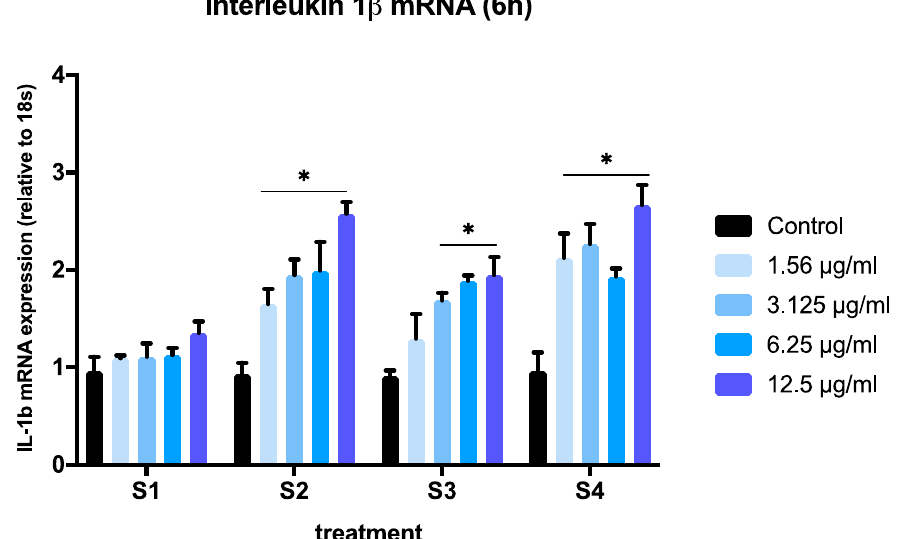
Figure 4. Expression of human interleukin-1 mRNA (IL1B) (relative to 18S expression) in BEAS-2B cell after exposure to soot preparations for 6 h. The graph summarizes data from three independent experiments ( n = 3 replicates per experiment), with results normalized to controls (exposed to methanol) and expressed as mean ± SEM. Two-way ANOVA interaction: p = 0.0109, F (12, 71) = 2.415; concentration effect: p < 0.0001, F (4, 71) = 30.51; soot type effect ( p < 0.0001, F (3, 71) = 15.48). * p < 0.05, different from control (Dunnett’s multiple comparison’s test). For a description of S1–S4, see Section 2.